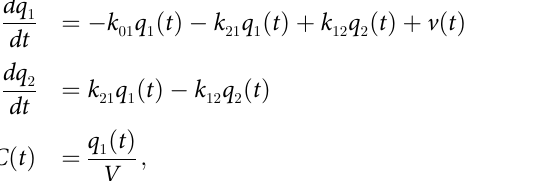
PLOS ONE | https://doi.org/10.1371/journal.pone.0276654 November4,